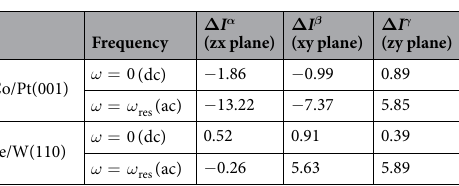
Frequency ω = 0 (dc) − 1.86 Co/Pt(001)